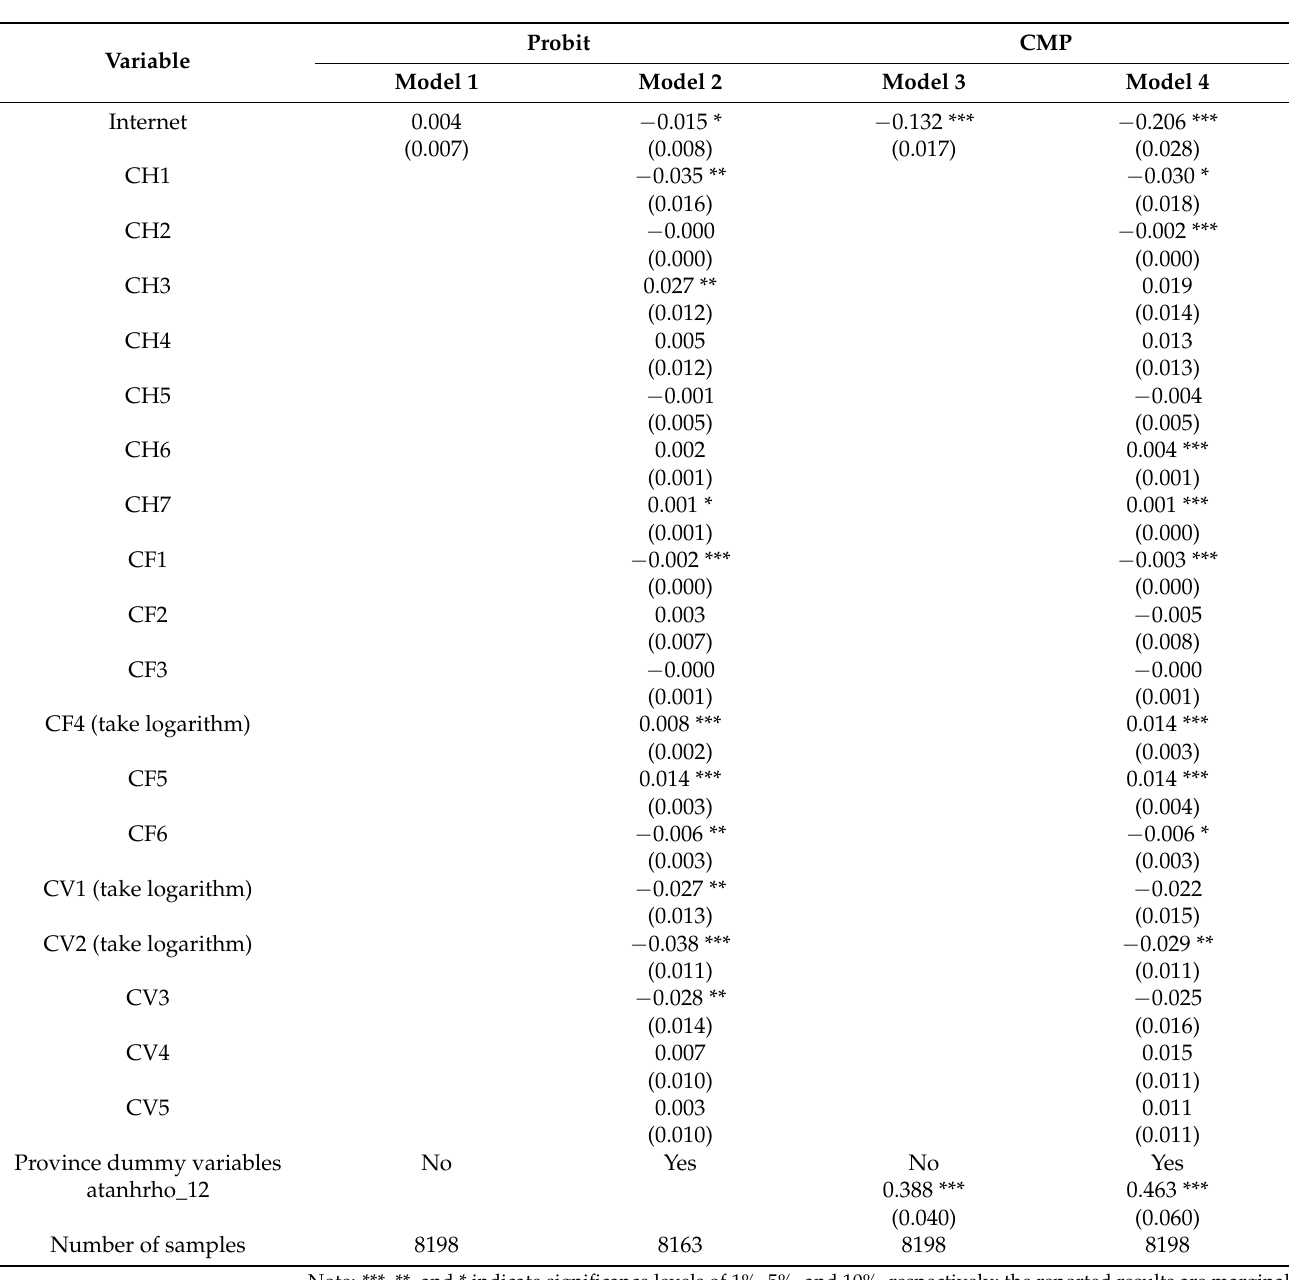
Table 2. Basic regression